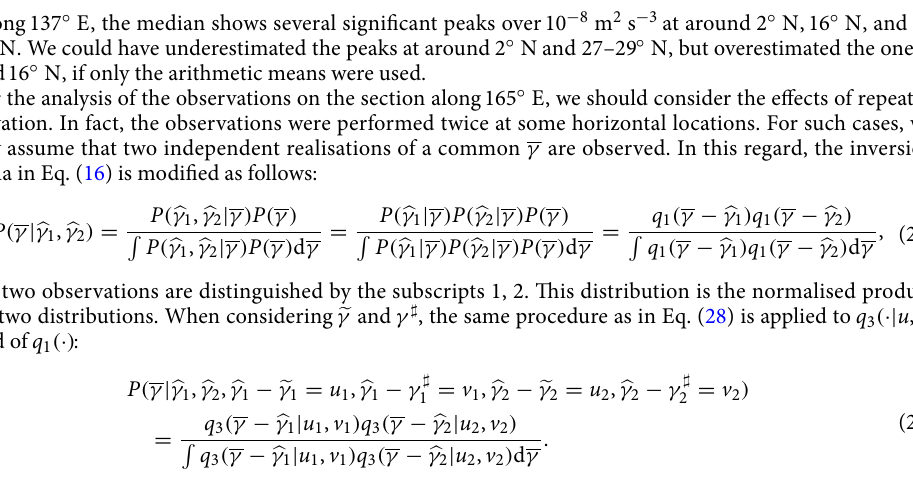
Figure 14. Geographical distribution of median (purple dots) and confidence interval (purple shade) of ǫ along 165 ◦ E . The effect of repeated observation is considered in ( b ), but not in ( a ). The horizontal axis shows the location. Arithmetic mean (orange) and geometric mean (blue) are also